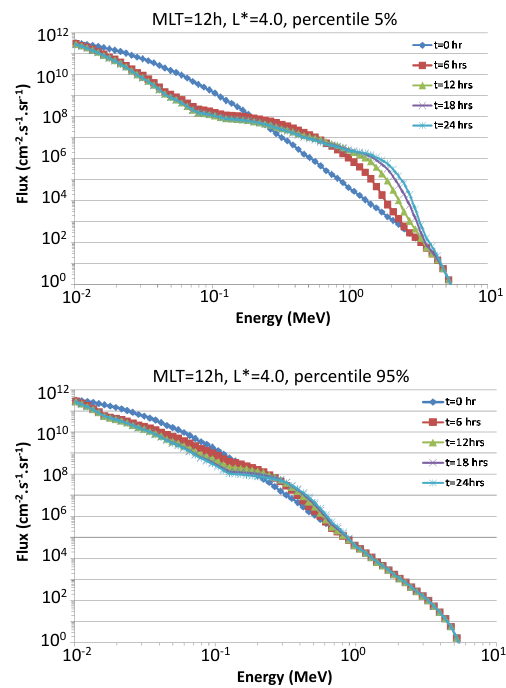
Figure 8. Time evolution of electron flux due to chorus and hiss waves at MLT = 12h for L ∗ = 4.0 using extreme electron plasma density values: percentile 5% on top (low density) and percentile 95% on bottom (high density). The flux is shown at interval of 6 hours.